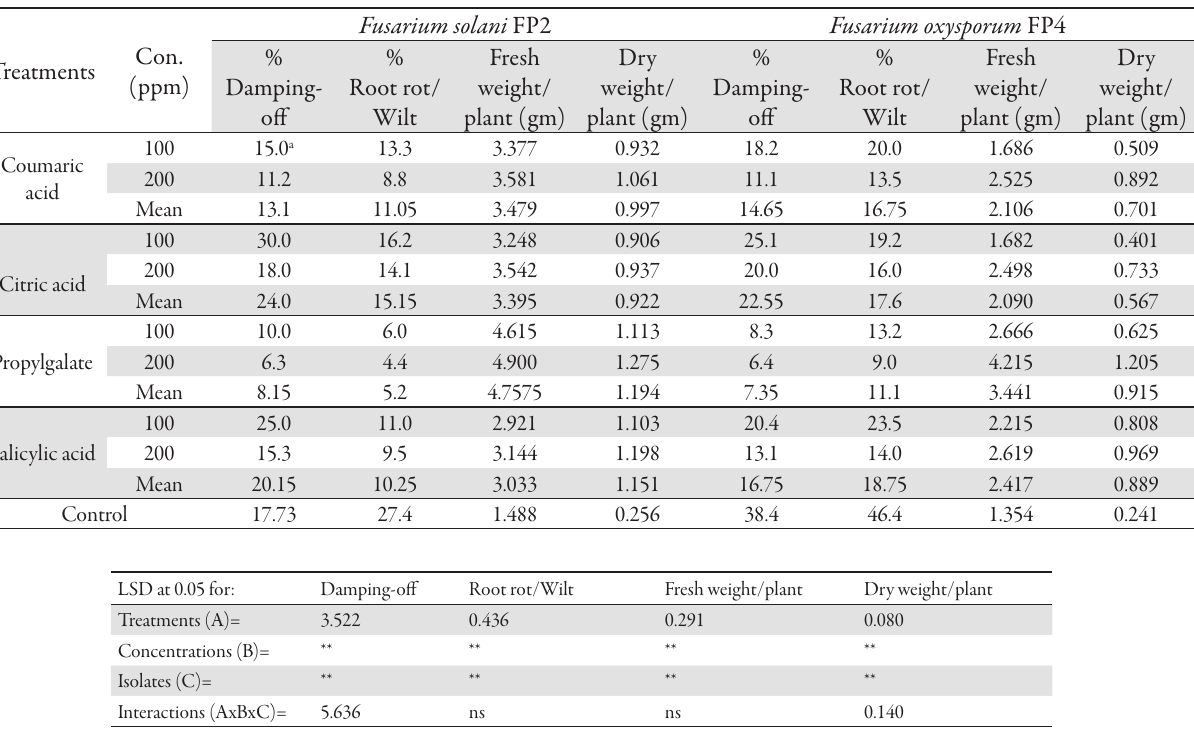
Tab. 2. Effect of pepper seed soaking in antioxidant solutions on damping- off and root rot/wilt caused by Fusarium solani isolate FP2 and Fusarium oxysporum isolate FP4 in pots